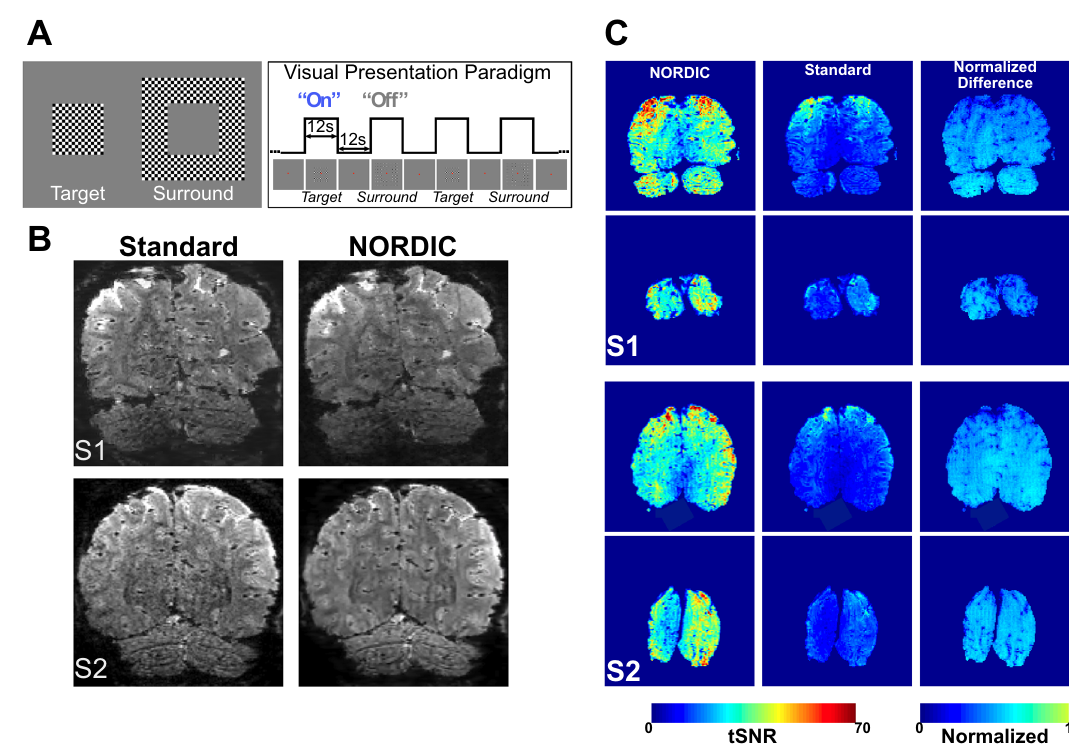
Fig. 1 Stimuli and paradigm, epi images, and tSNR. Panel A depicts the visual stimuli (left) used and a schematic of the visual presentation paradigm (right). Panel B shows an example slice from a single volume extracted from an fMRI time series for Standard (left column) and NORDIC (right column) reconstructions before any preprocessing, for two subjects S1 and S2. Panel C shows average (across all 8 runs) brain temporal signal-to-noise ratio (tSNR) maps of 2 exemplar slices in 2 representative subjects (S1 and S2) for NORDIC (left) and Standard (center) reconstructions and the normalized difference between the 2. The last was computed by performing (tSNR NORDIC -tSNR STANDARD )/tSNR NORDIC ). The slices chosen represent one of the anterior-most slices in the covered volume, and an occipital slice that includes a portion of the target ROI in